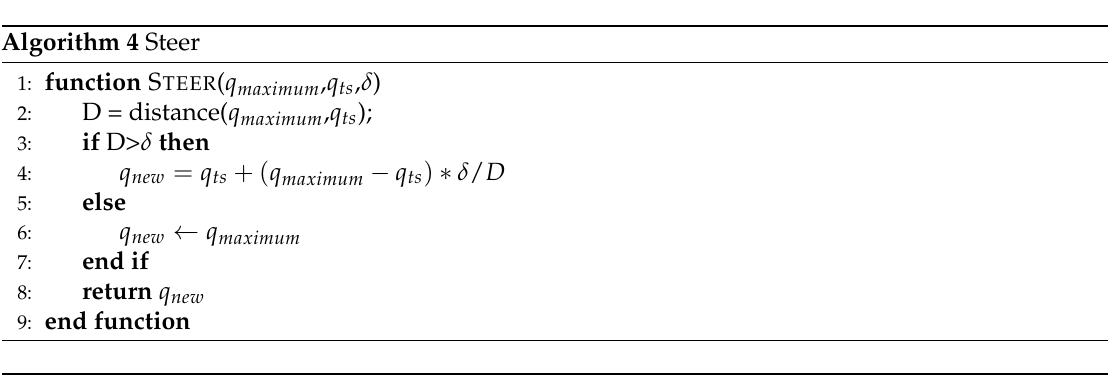
Algorithm 5 Collision Free